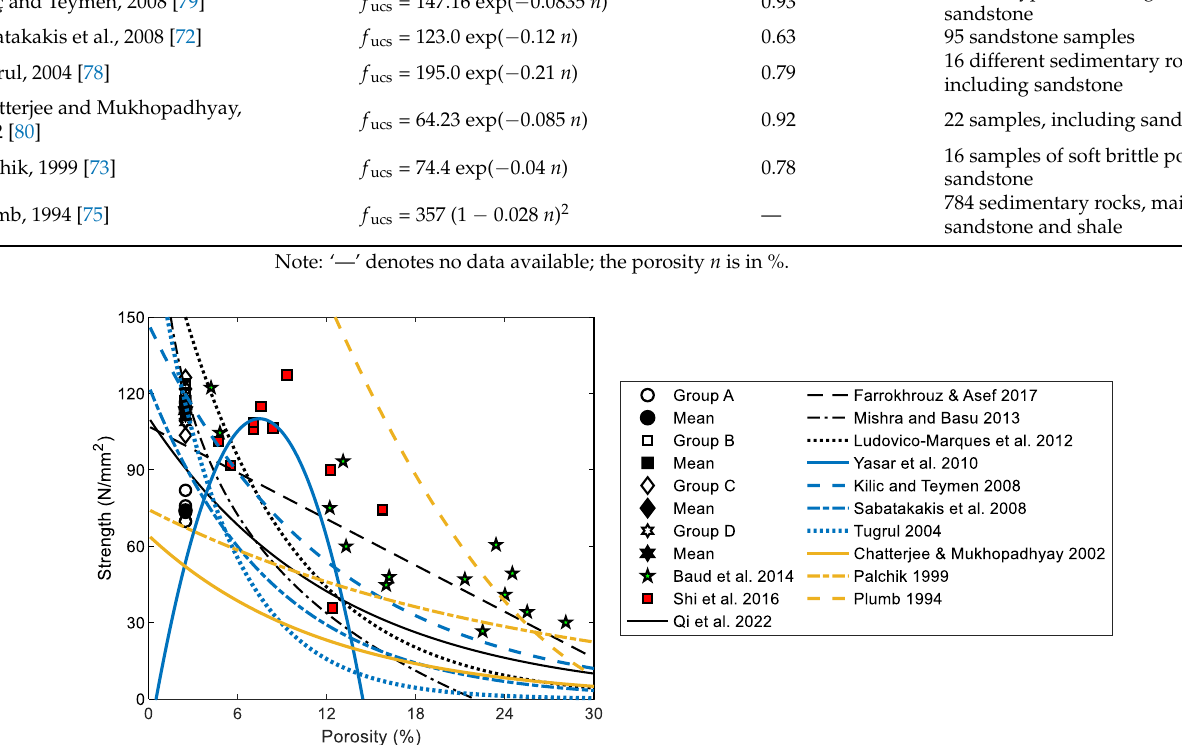
Figure 10. Compressive strength